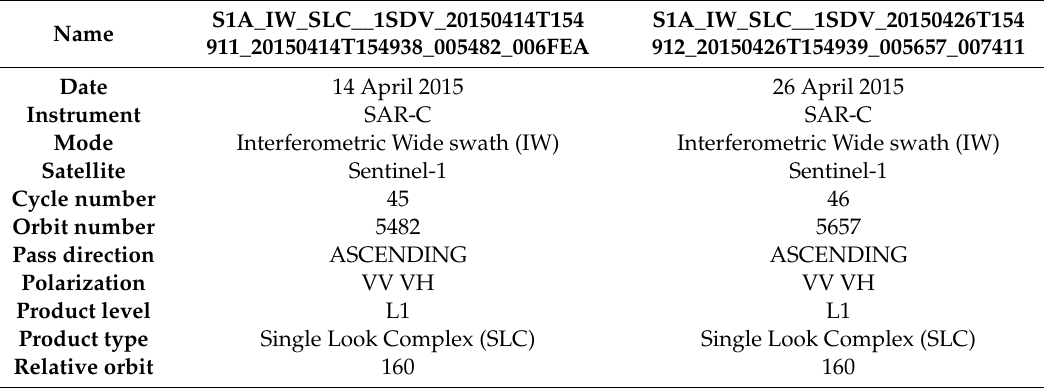
Table 1. Sentinel-1 synthetic aperture radar (SAR) image